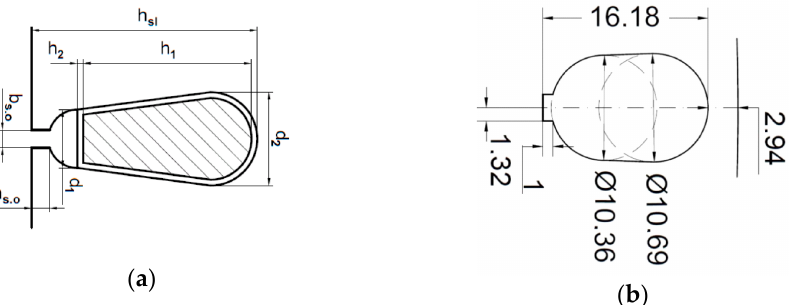
Figure 5. O-shaped (oval) slots for single section of modular sectional motor: ( a ) dimension units; ( b ) slot in scale with dimension.